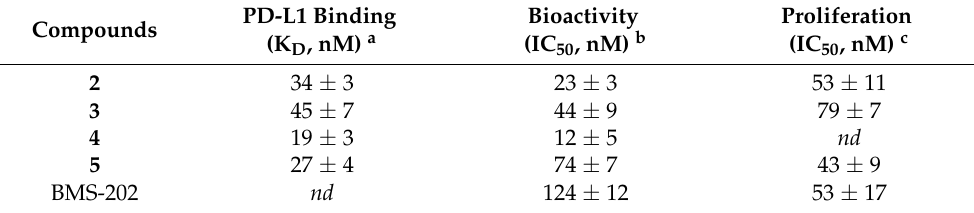
Figure 4. MST binding assays for PD-L1 binding: ( a ) Dose response curves for the binding of compounds 2–5 to recombinant human PD-L1. Graphs are represented as fraction bound against ligand concentration. Data represent three independent experiments (n = 3) and were fitted to a K D -binding model assuming a 1:1 binding stoichiometry. ( b ) Drug-induced formation of PD-L1 dimers monitored by MST. In these experiments, a fluorescent tagged PD-L1 protein incubated with the test compound is titrated with the unlabeled (non-fluorescent) protein, as represented graphically. Table 1. PD-L1 binding and regulatory properties of the test compounds.